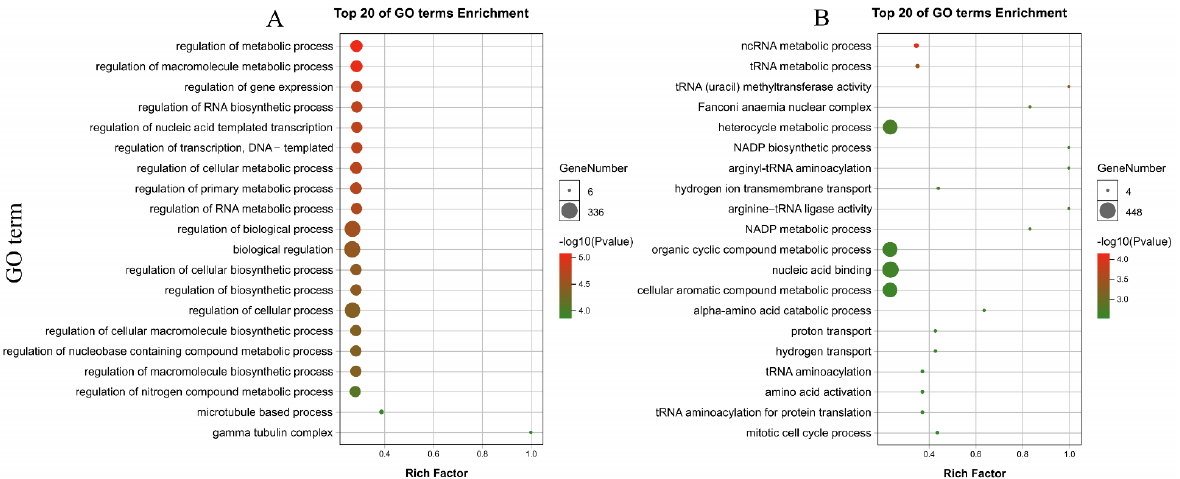
Figure 12. The top 20 significantly enriched GO terms for target genes. ( A ): Top 20 significantly enriched GO terms for AP2 target genes. ( B ): Top 20 significantly enriched GO terms for ERF/DREB target genes.